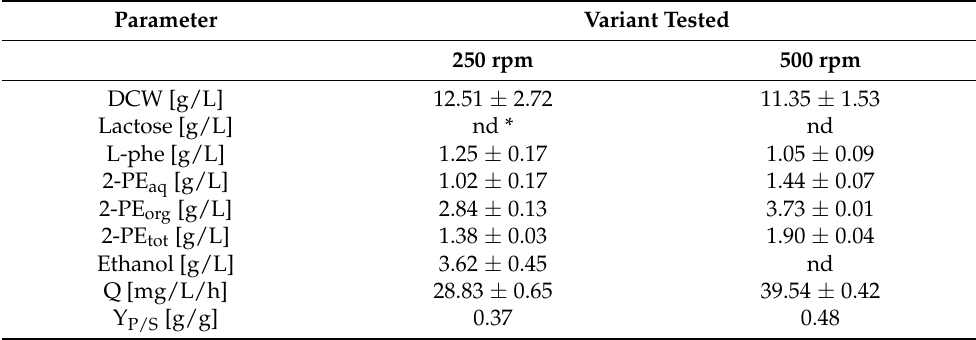
Table 2. Parameters of 48 h two-phase batch cultures of K. marxianus WUT240 in WP25 medium at 30 ◦ C in 4.8-L bioreactor. Analyses were performed in duplicate and data are presented as the mean ±